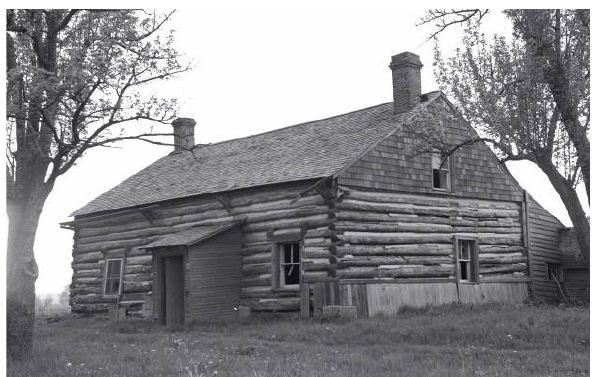
Figure 1. Log cabin in Victoria Park Ave., at end of Ellesmere Rd, Toronto, 1956 (Source: Courtesy of Toronto Public Library).